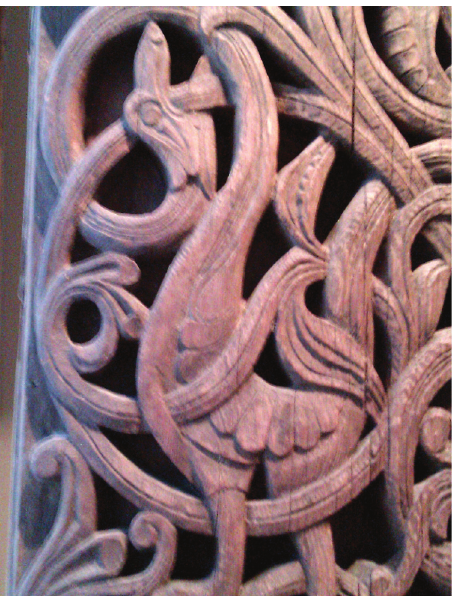
Figure 4: Inhabited vine on the Sauland por- tal. Photo: